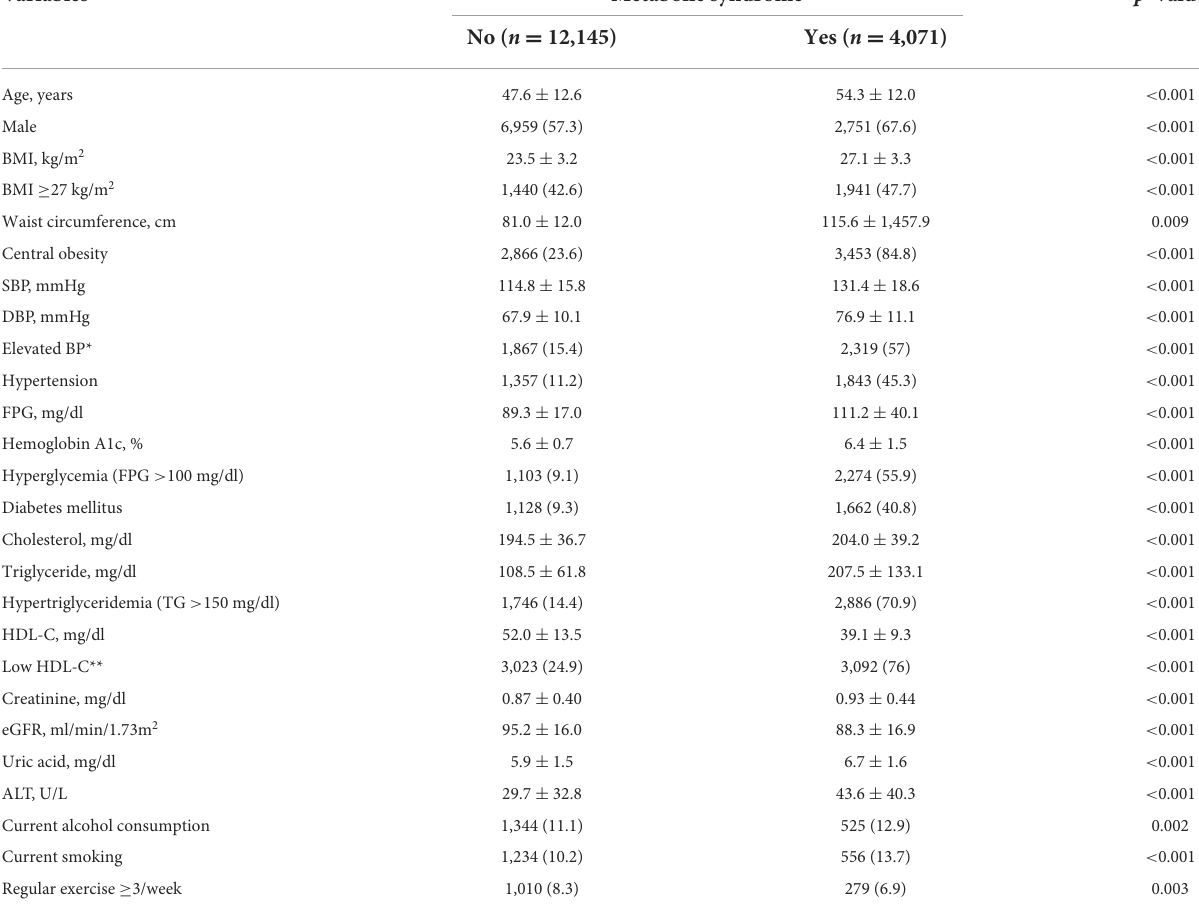
TABLE 1 Comparisons of clinical characteristics between subjects with and without metabolic